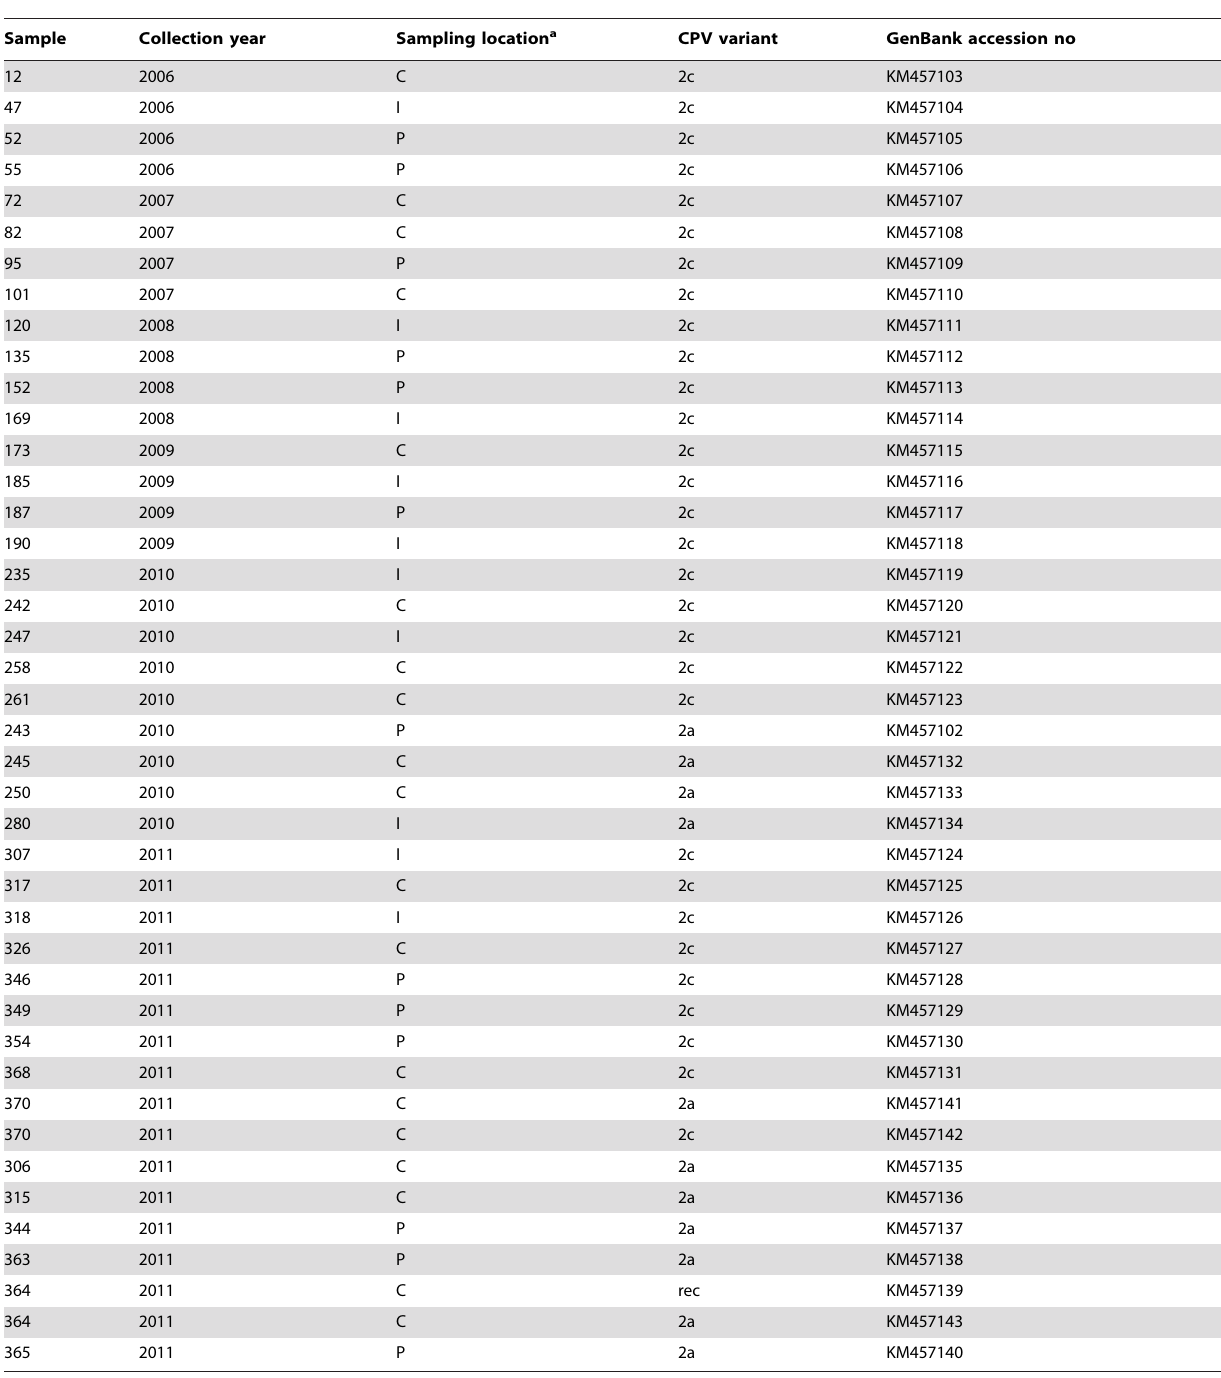
Table 1. Uruguayan dog fecal samples used in this